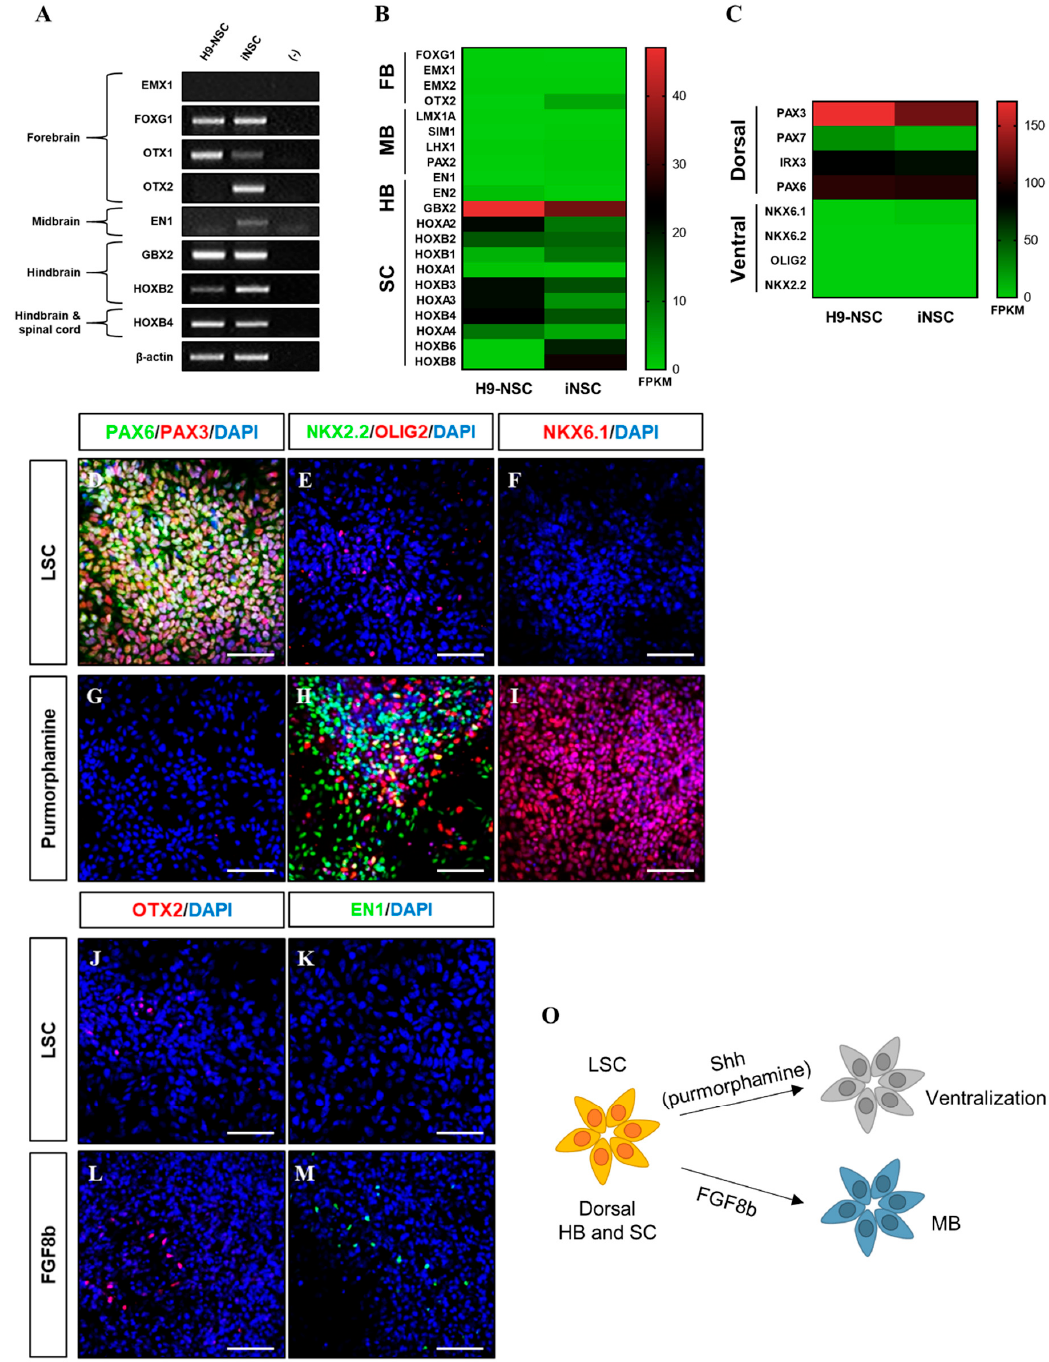
Figure 3. Developmental region-specific patterning of iNSCs. ( A ) RT-PCR analysis of forebrain, midbrain, hindbrain, and spinal cord markers in iNSCs and H9-NSCs. ( B ) Analysis of central nervous system (CNS) region-specific maker expression in H9-NSCs and iNSCs by RNA sequencing. FB, forebrain; MB, midbrain; HB, hindbrain; and SC, spinal cord. ( C ) Identification of dorsal and ventral-specific marker expression in H9-NSCs and iNSCs by RNA sequencing. ( D – I ) Purmorphamine treatment induces ventral markers (NKX2.2, OLIG2, and NKX6.1) and decreases dorsal markers (PAX3 and PAX6) of iNSCs, as determined by immunofluorescence analysis. ( J – M ) Forebrain marker (OTX2) and midbrain marker (EN1) expression in iNSCs under LSC culture medium or FGF8b treatment, as determined by immunofluorescence analysis. ( O ) Schematic diagram of region-specific patterning of iNSCs. Scale bars, 200 µ